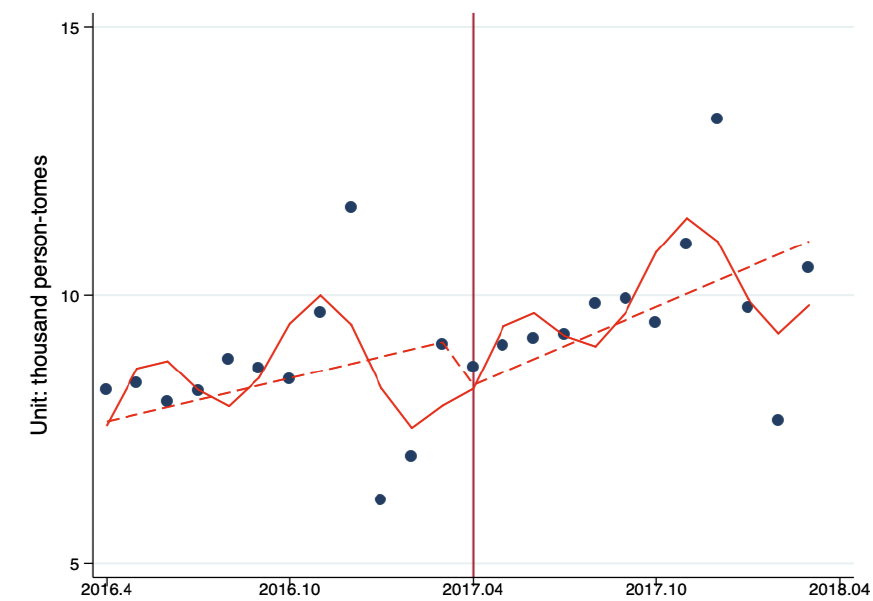
Figure 1. The ITS analysis of monthly outpatient visits in per primary healthcare (PHC) institution. Model adjusted for seasonality and autocorrelation. Solid line: Predicted trend based on the seasonally adjusted regression model. Dashed line: De-seasonalized trend. Vertical line: Intervention began. Blue dots: Actual number. Table 5. The impacts of the Beijing Reform on monthly outpatient visits per healthcare facility type.